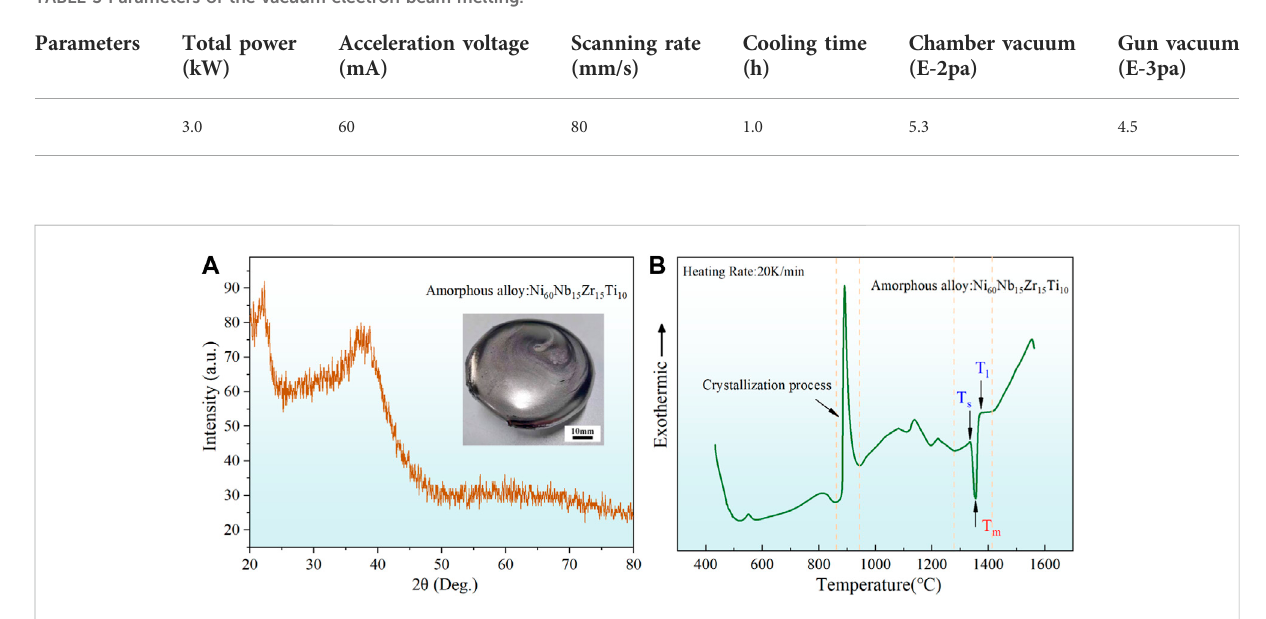
TABLE 3 Parameters of the vacuum electron beam melting.